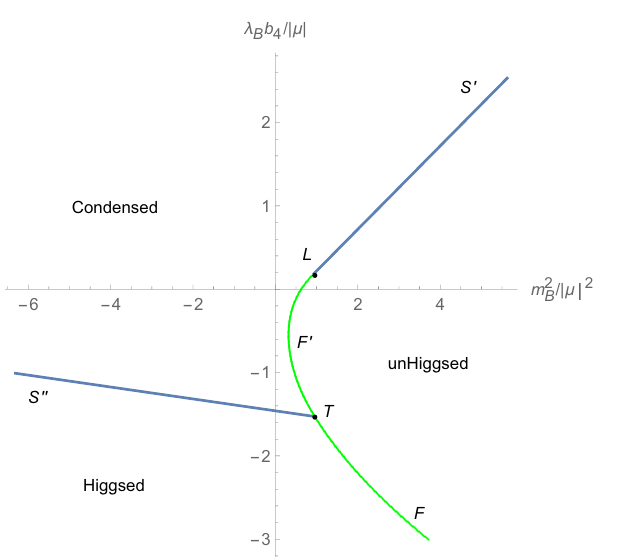
Figure 21 . The phase diagram of the regular boson theory for | λ B | = 1 is in the stable range 0 < x B